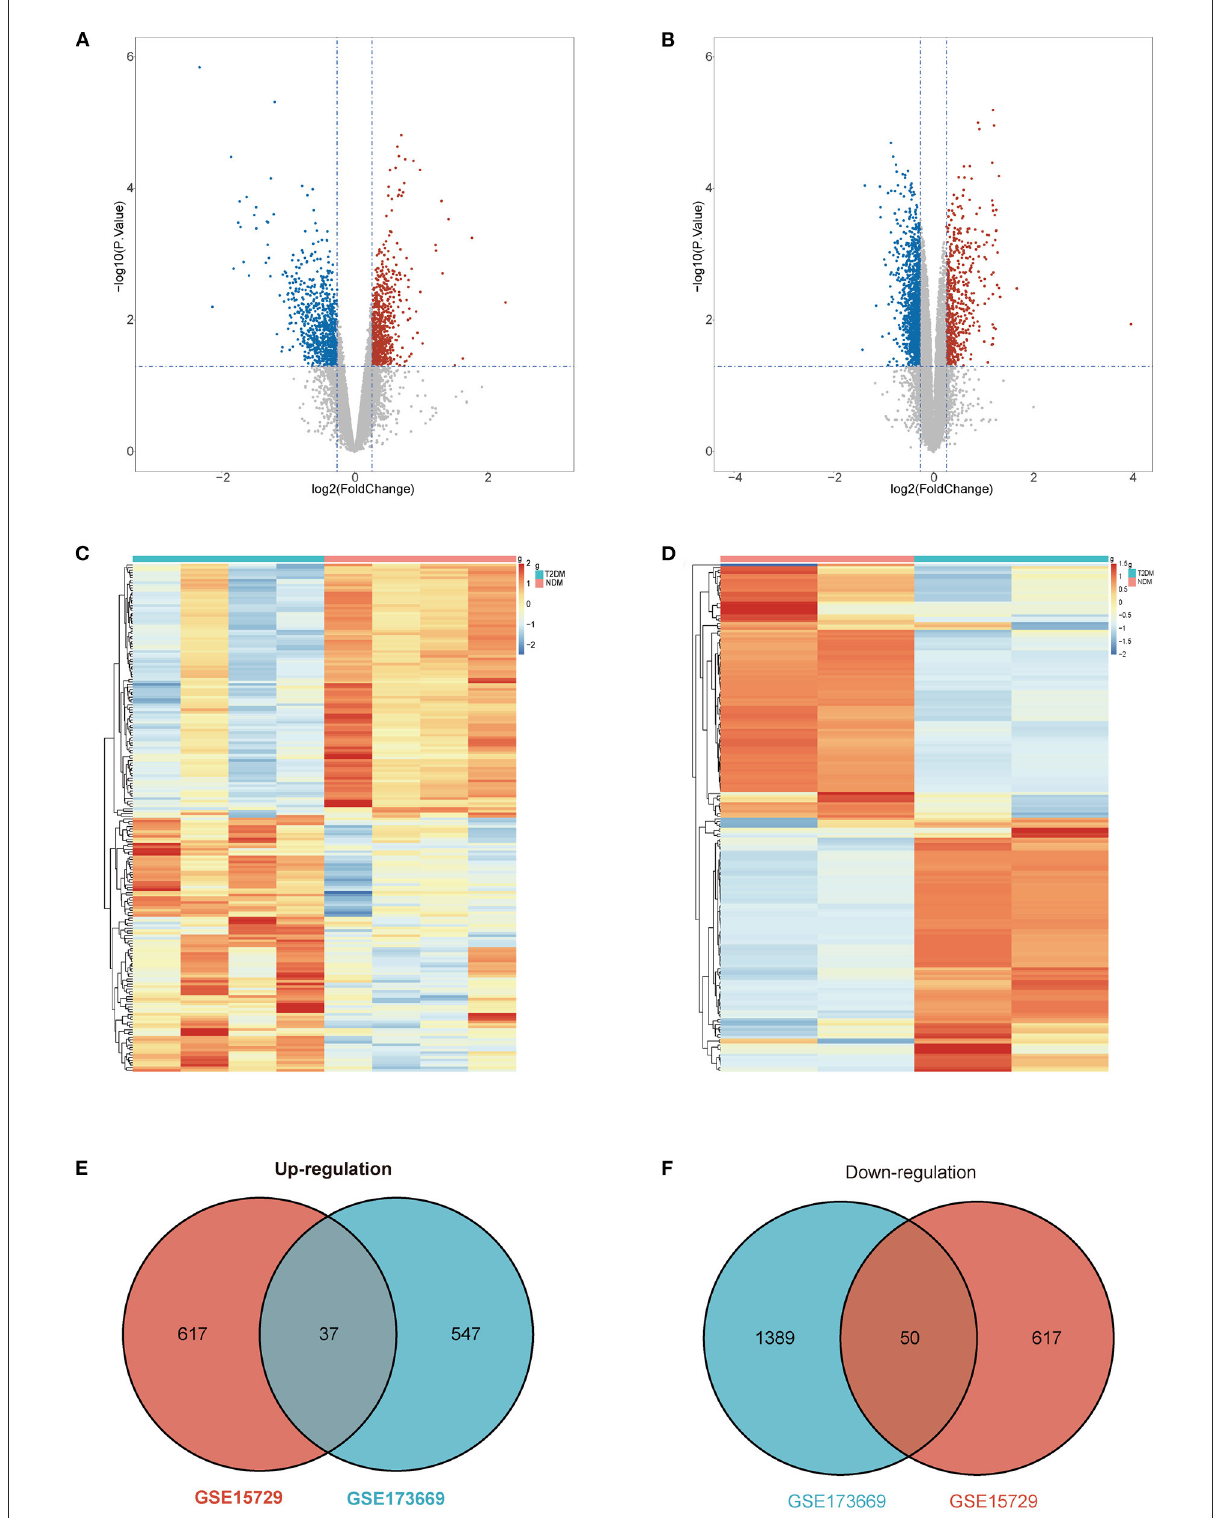
FIGURE2 Differential expression genes (DEGs). (A) Volcano plot of GSE15729. (B) Volcano plot of GSE173669. (C) Heatmap of GSE15729. (D) Heatmap of GSE173669. (E) Venn diagram of common up-regulated DEGs from the two datasets. (F) Venn diagram of common down-regulated DEGs from the two[[Inline Image]]